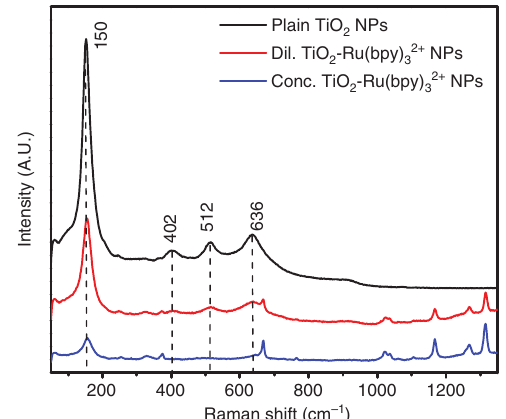
, diluted TiO -Ru(bpy) 32 + 2 2